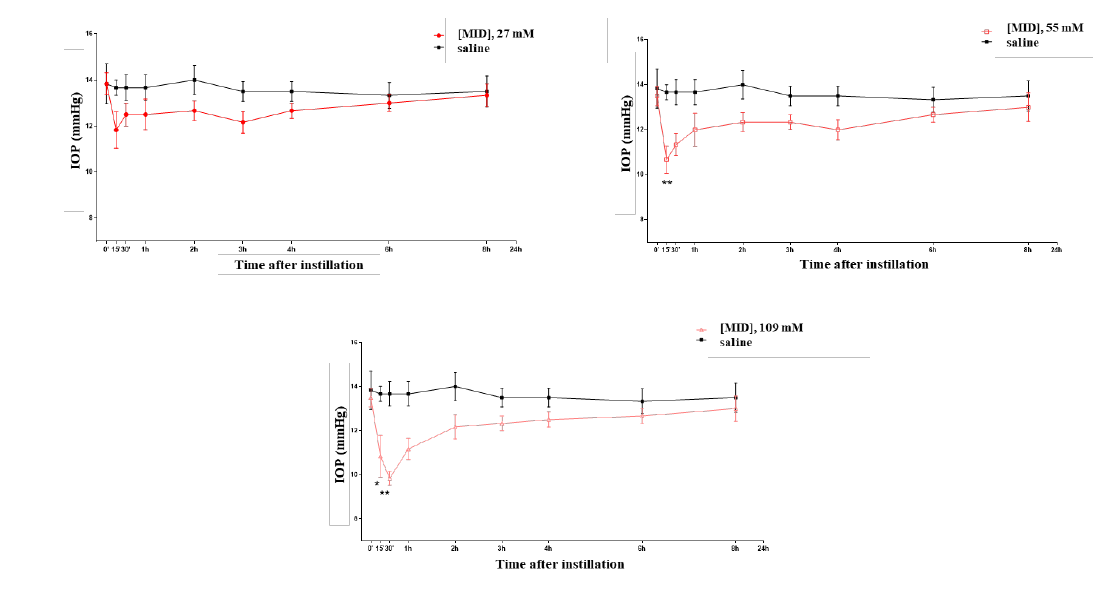
Figure 2. Effects on the IOP of meldonium (MID) eye drops at increasing concentrations. * p < 0.05; ** p < 0.01.